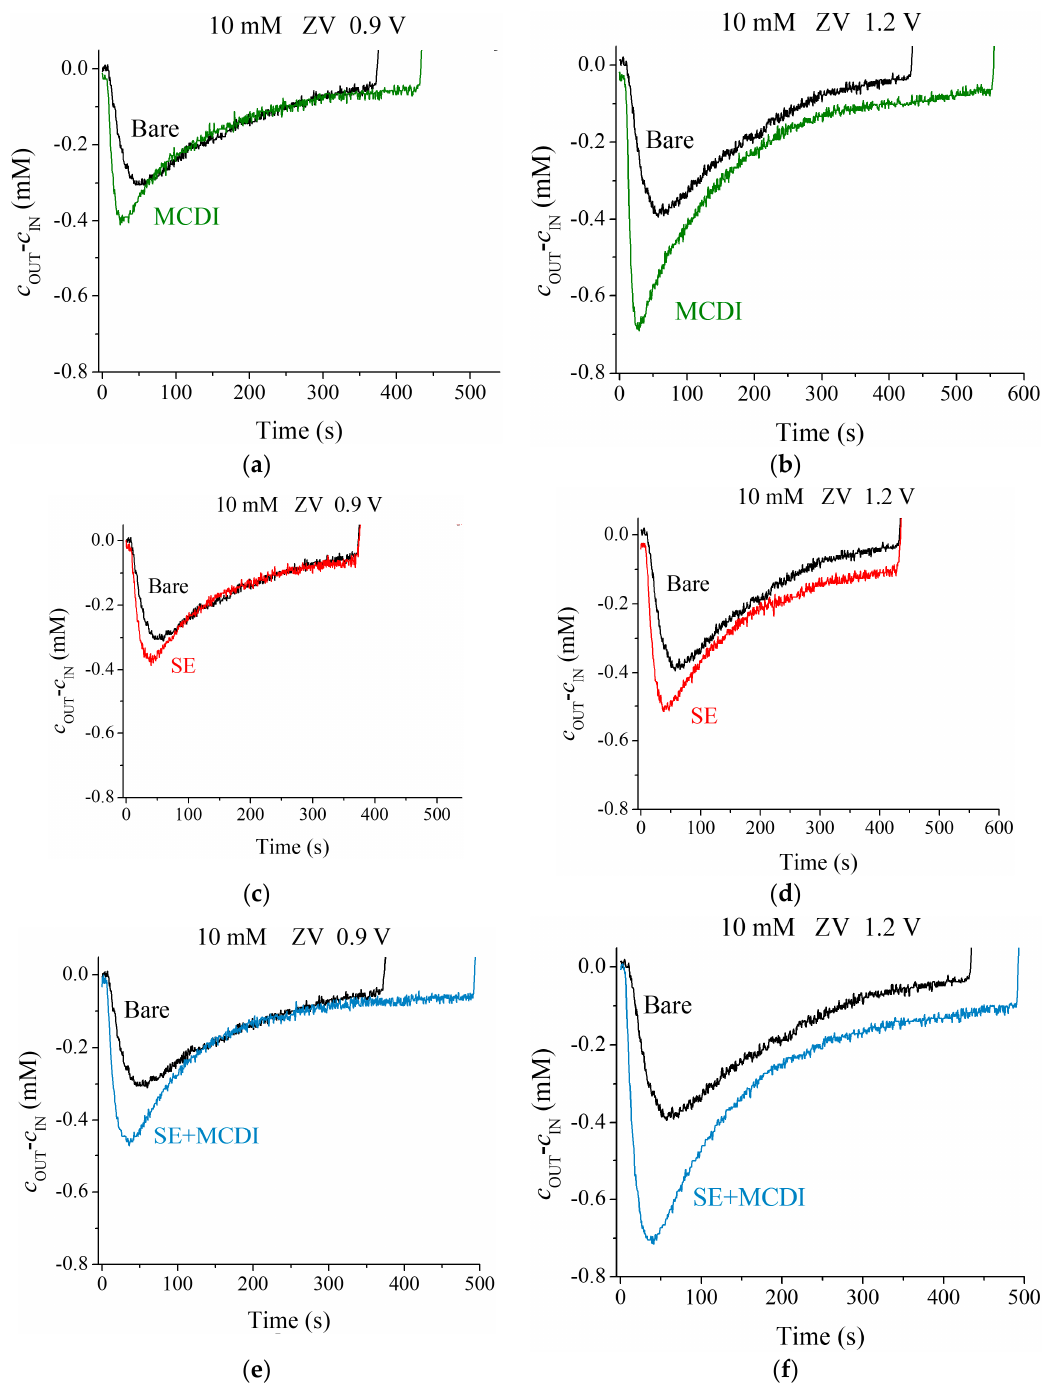
Figure 3. Solution concentration difference between the exit and input of the cell for applied voltages of 0.9 and 1.2 V, and a 10 mM NaCl feed solution. Comparison between bare carbon electrodes with membrane capacitive deionization (MCDI) ( a , b ), soft electrodes (SE) ( c , d ), and SE + MCDI electrodes ensembles ( e , f ). All the cycles were performed at ZV desorption.